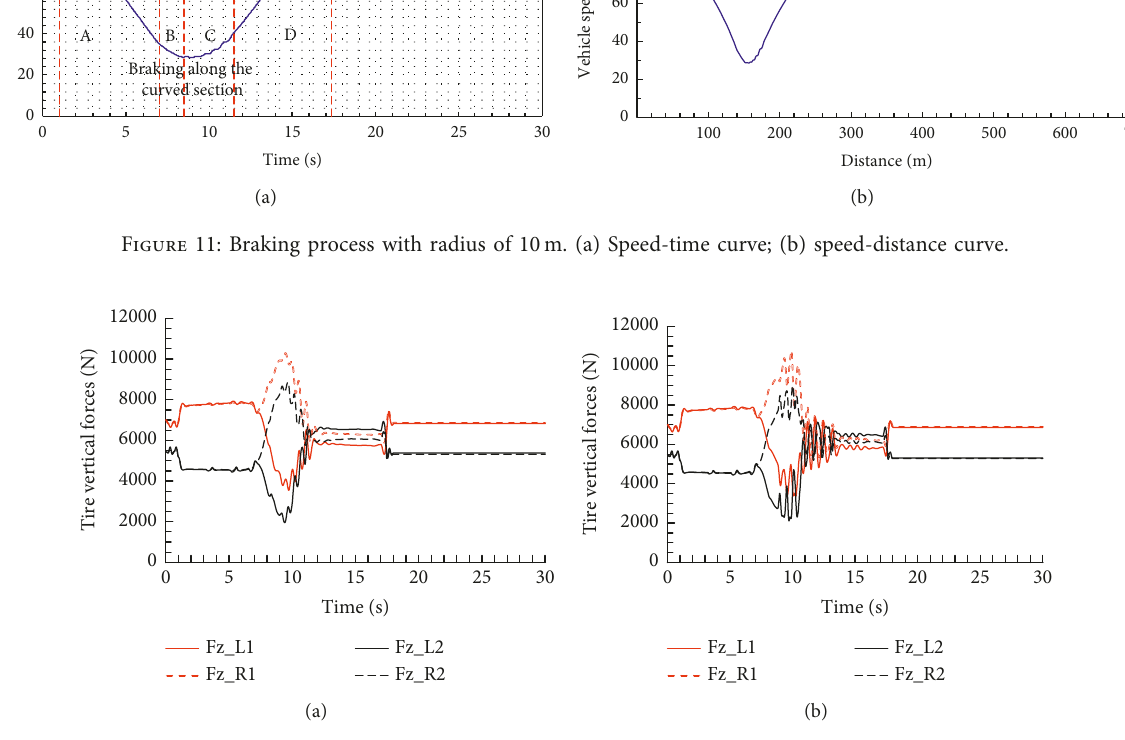
Figure 12: Tire vertical force curves with the curve radius of 10m. (a) On dry road; (b) on wet road. Note: FZ_L1 and FZ_L2 are, respectively, the tire vertical force of left front wheel and left rear wheel of vehicles; FZ_R1 and FZ_R2 are, respectively, the tire vertical force of right front wheel and right rear wheel of vehicles, which are similar to those in Figures 13 and